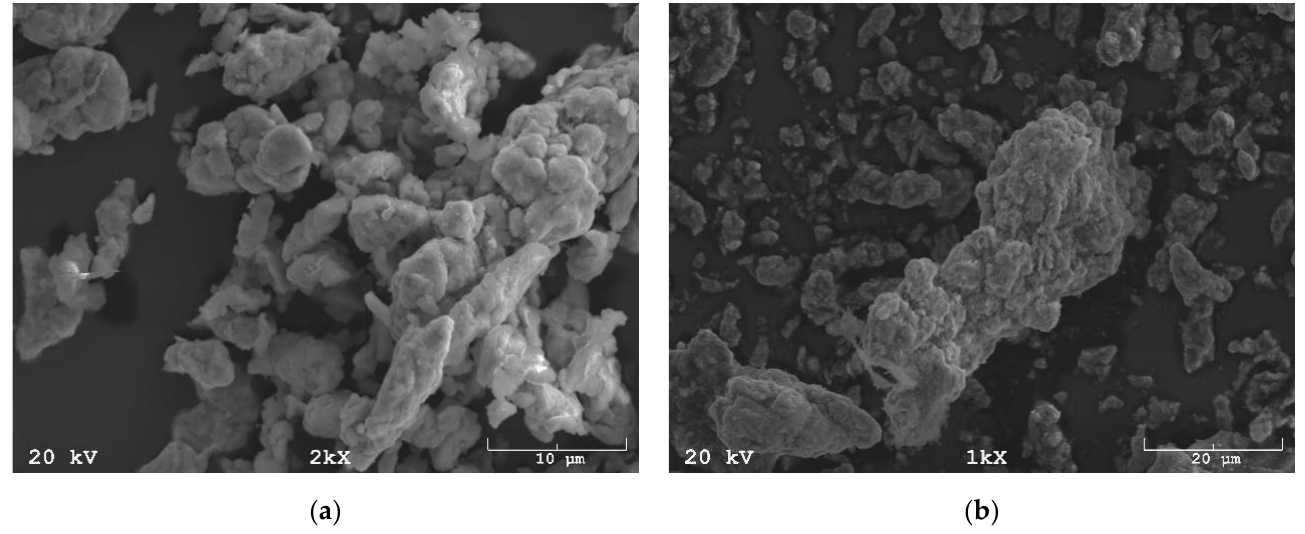
Figure 4. Morphology of the particles of copper with tuff after homogenization: ( a ) 5% wt. of tuff at a magnification of 2000×; ( b ) 30% wt. of tuff at a magnification of 1000X.